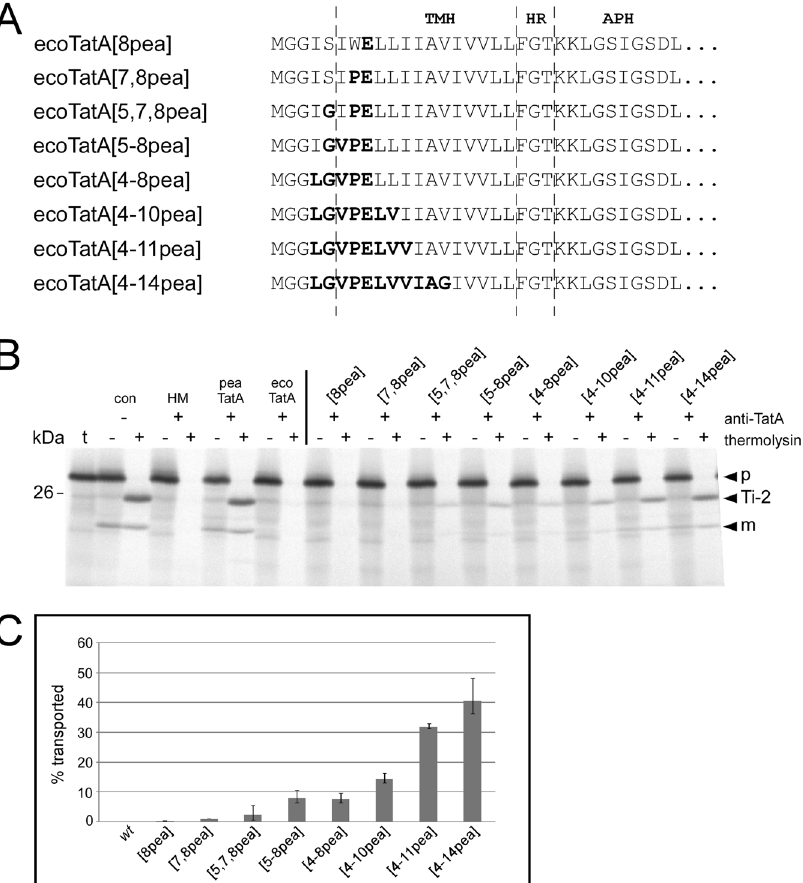
Figure 6. Catalytic activity of mutant derivatives of E. coli TatA carrying single amino acid substitutions within TMH. ( A ) Amino acid sequence of the N-terminal regions of the chimeric TatA proteins analysed here. ( B ) I n thylakoido complementation assays analysing the chimeric TatA proteins shown in ( A ). ( C ) Quantitation of catalytic activities of three (n = 3) independent experiments as shown in ( B ) given as percentage of the transport rate determined for the antibody-treated assays supplemented with pea TatA. For further details see the legends to Figs 1, 2, and